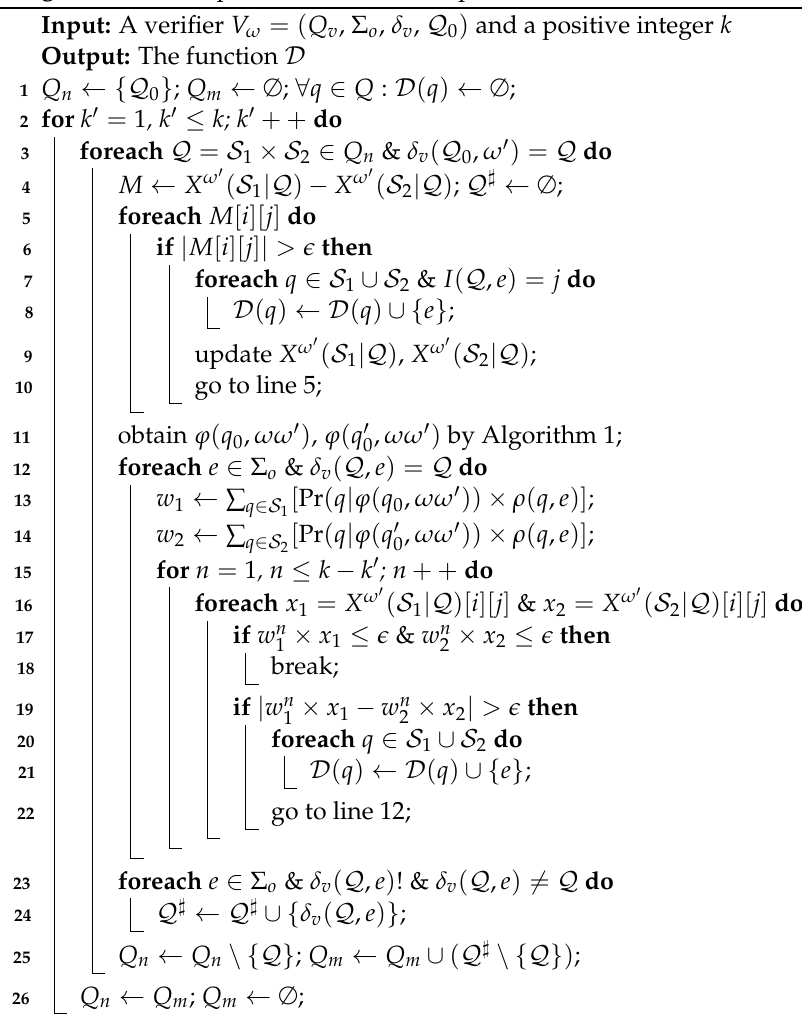
Algorithm 4: Computation of a control